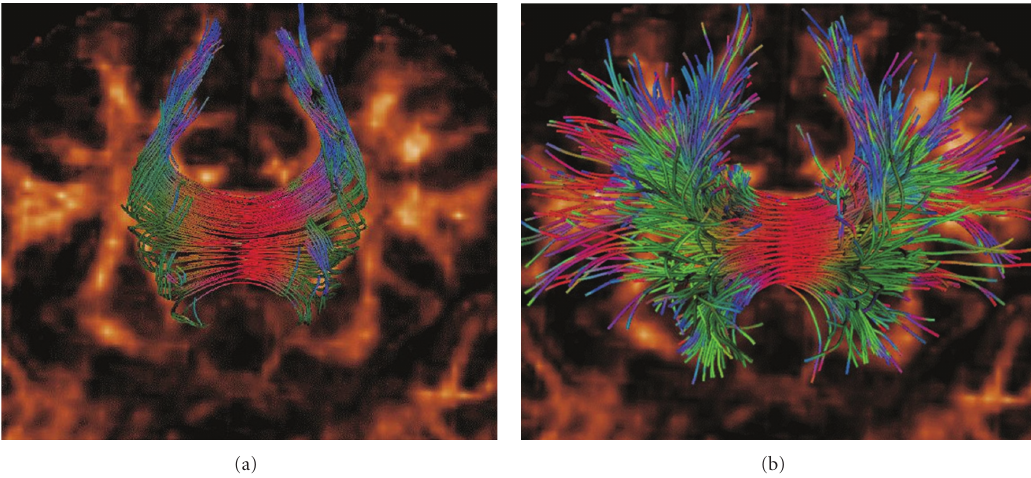
Figure 3: Fibers of part of the corpus callosum, computed using the streamlines method (a) and the geodesic ray-tracing method (b). Fibers were computed from seed points located in the center of the corpus callosum and are colored according to their local orientation (similar to the glyphs in Figure 1). Unlike the streamline method, which only captures the most dominant bundles of the corpus callosum, the geodesic ray-tracing method is able to correctly detect the divergence of the fiber bundles. This image was generated in the DTITool